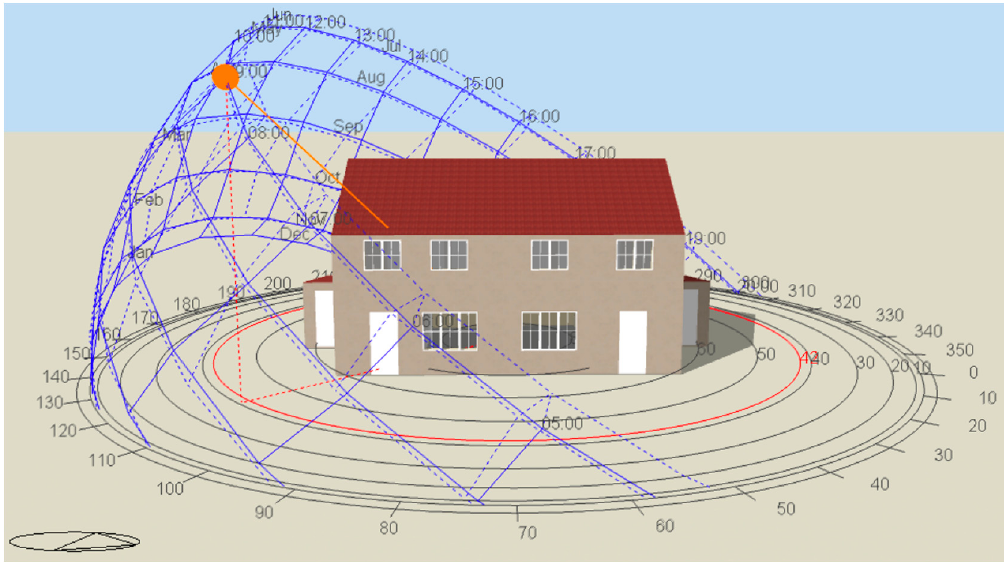
Figure 11. DesignBuilder model from which the EnergyPlus Input Definition File (IDF) was created.